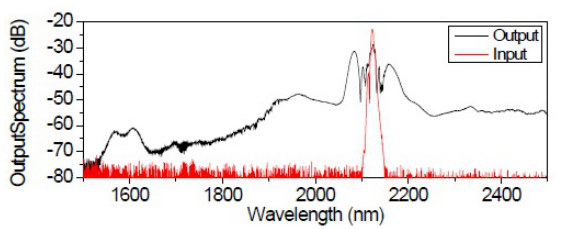
Fig. 21. Supercontinuum generation in a 900 nm wide and 220 nm thick silicon waveguide. The input and output spectrum of the pulse train shows the dramatic spectral broadening of the pulses after propagating through a 2 cm long nanowire waveguide. Adapted from reference [57].